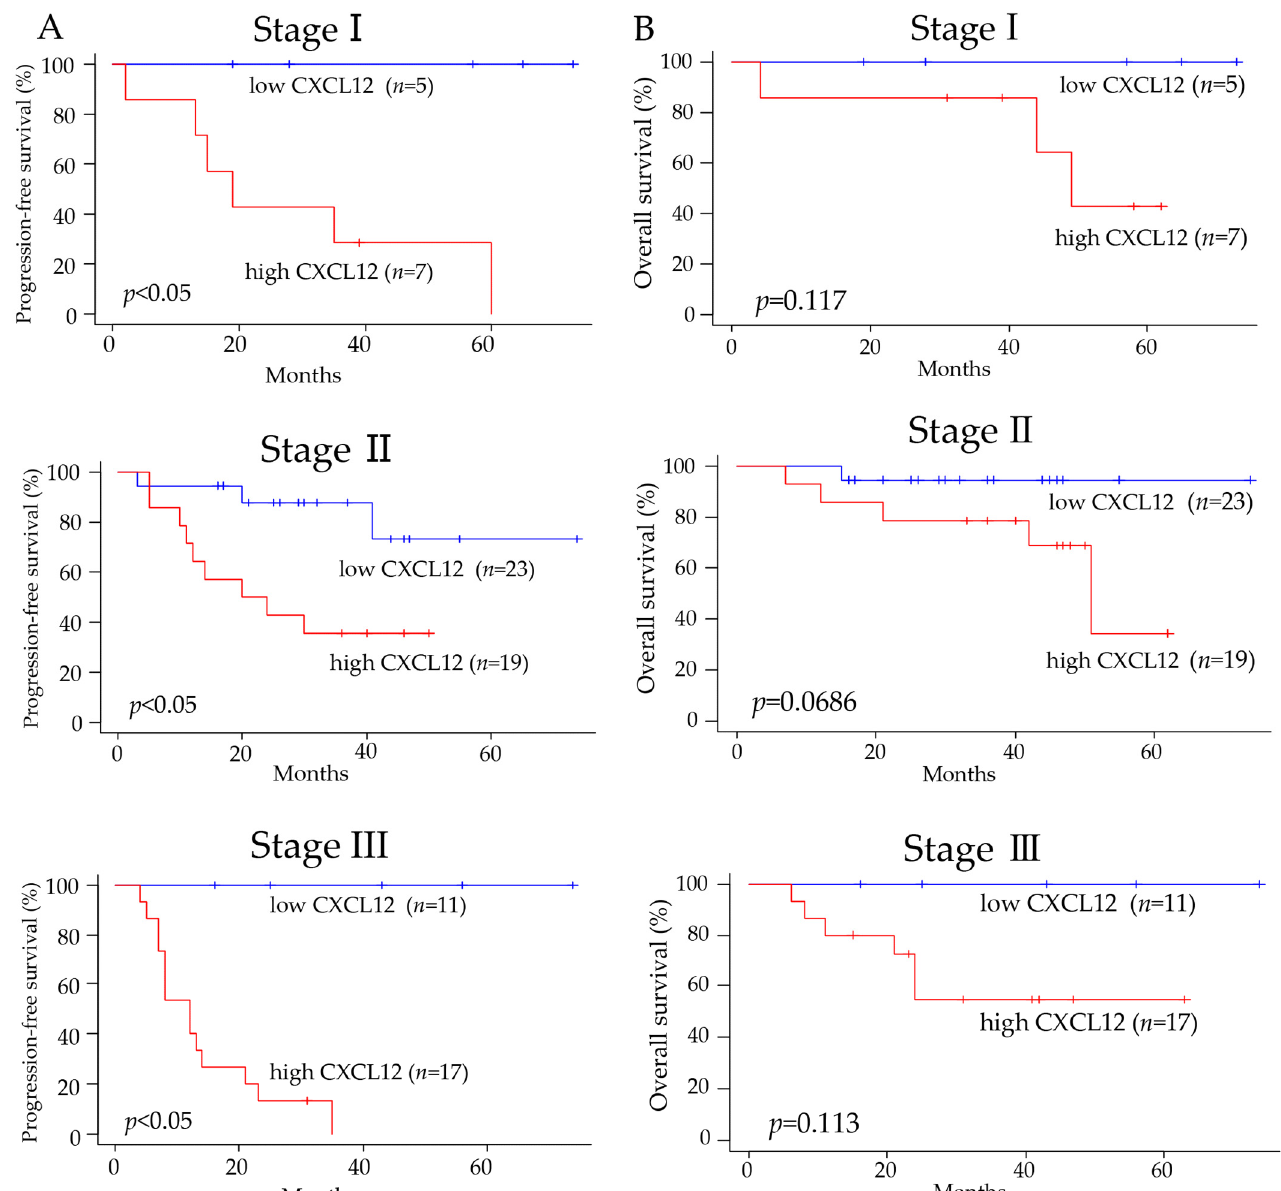
Figure 4. Amelioration of progression-free survival and overall survival in patients with tumors showing low expression of CXCL12 in each clinicopathological stage. ( A ) The progression-free survival was significantly different between patients showing low and high expression of CXCL12 in each pathological stage. ( B ) There was a trend for better overall survival in patients with tumors showing low expression of CXCL12. The Kaplan–Meier method was used to illustrate the data.